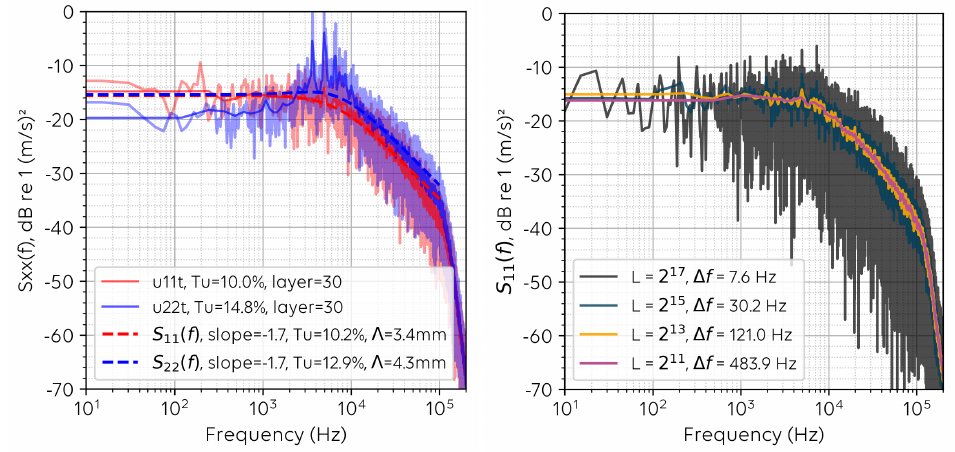
Figure 6. Velocity PSD of the point marked in Figure 5 at y ≈ − 0.10. ( Left ): both longitudinal (red) and transverse (blue) velocity components are plotted along with the respective fitted von Kármán spectra. ( Right ): PSD of the longitudinal velocity component estimated with four different window sizes (data tapper). The window sizes and frequency resolutions are marked in the label.